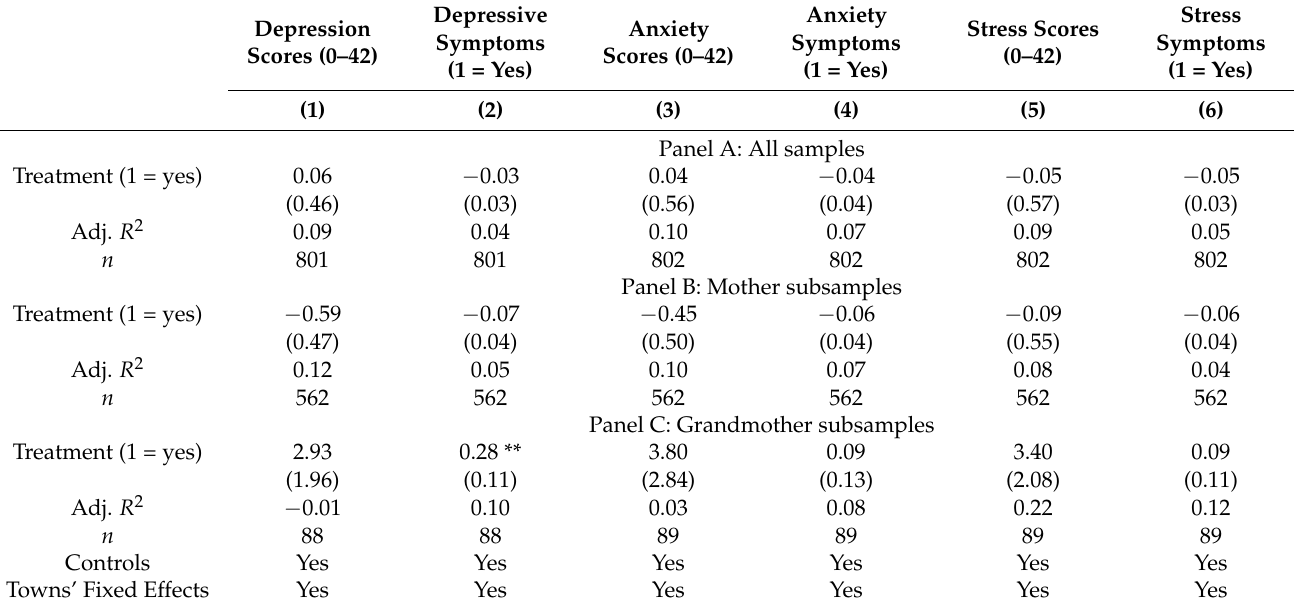
Table 4. Program average treated effect on the caregivers’ mental